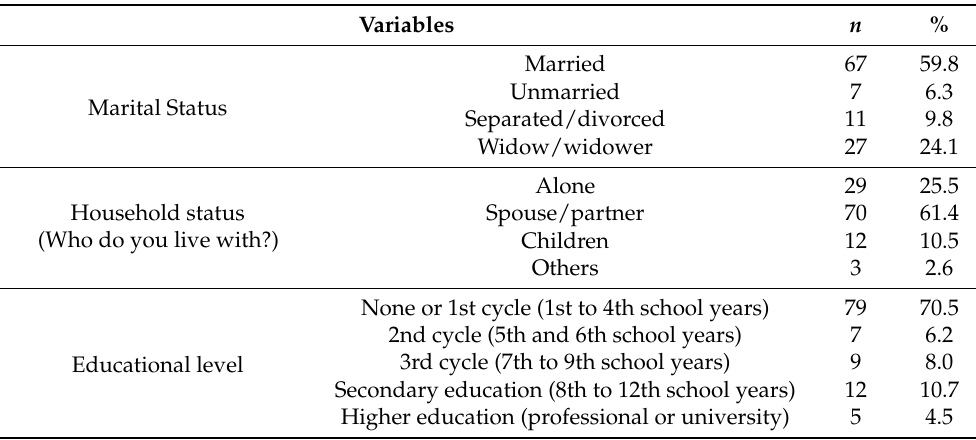
Table 1. Participants’ sociodemographic characteristics ( n = 112). Variables n